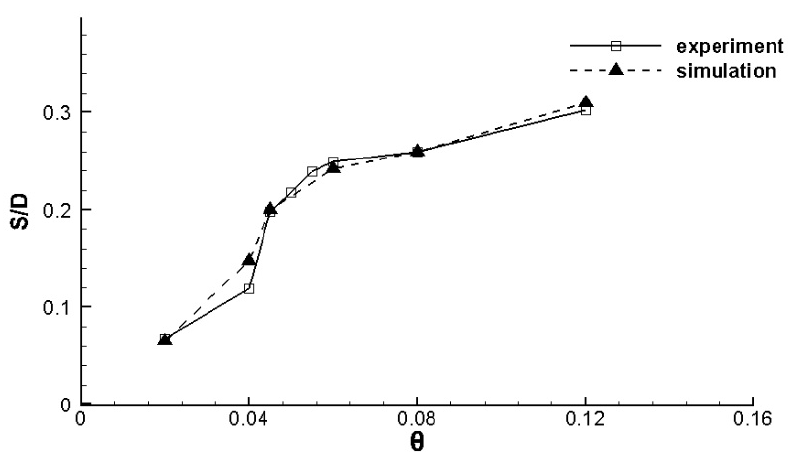
Figure 8. Dependence of the equilibrium scour depth on incoming Shields parameter. When the value of the undisturbed Shields parameter is 0.04, the calculated equilib- rium scour depth shows an apparent difference from the measured value in the experiment, which may be due to the relatively deep scour hole prescribed at t = 0 in the simulation. However, the comparison is still acceptable considering the large uncertainties in the ex- periments and empirical formulae used in the computation. In the case of other Shields numbers, θ ∞ = 0.045, 0.06, 0.08, 0.12, the calculated equilibrium scour depths are in excellent agreement with the experimental results, with errors no more than ± 0.01 D . The the correctness of the UDFs, can, thus, be